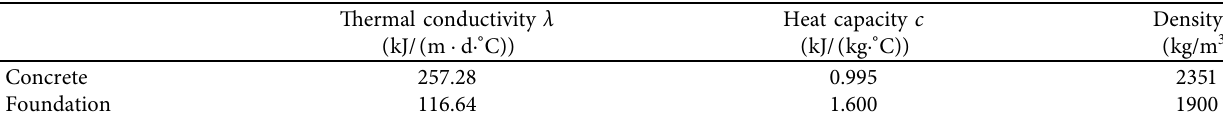
Table 7: Thermal parameters of the side